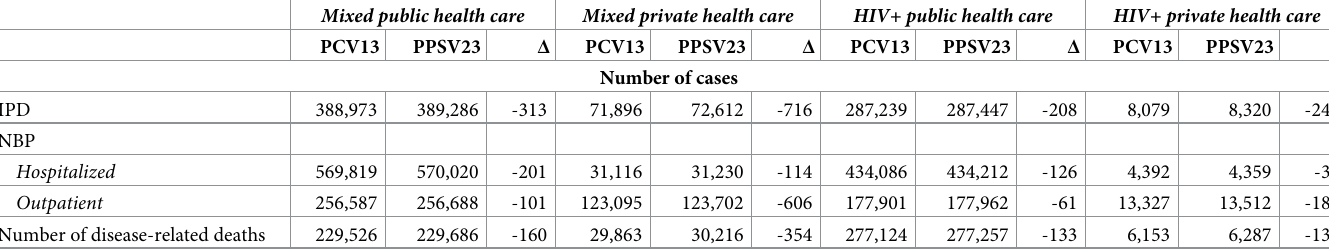
Table 8. The public health impact of PCV13 versus PPSV23 vaccination in South African adults.